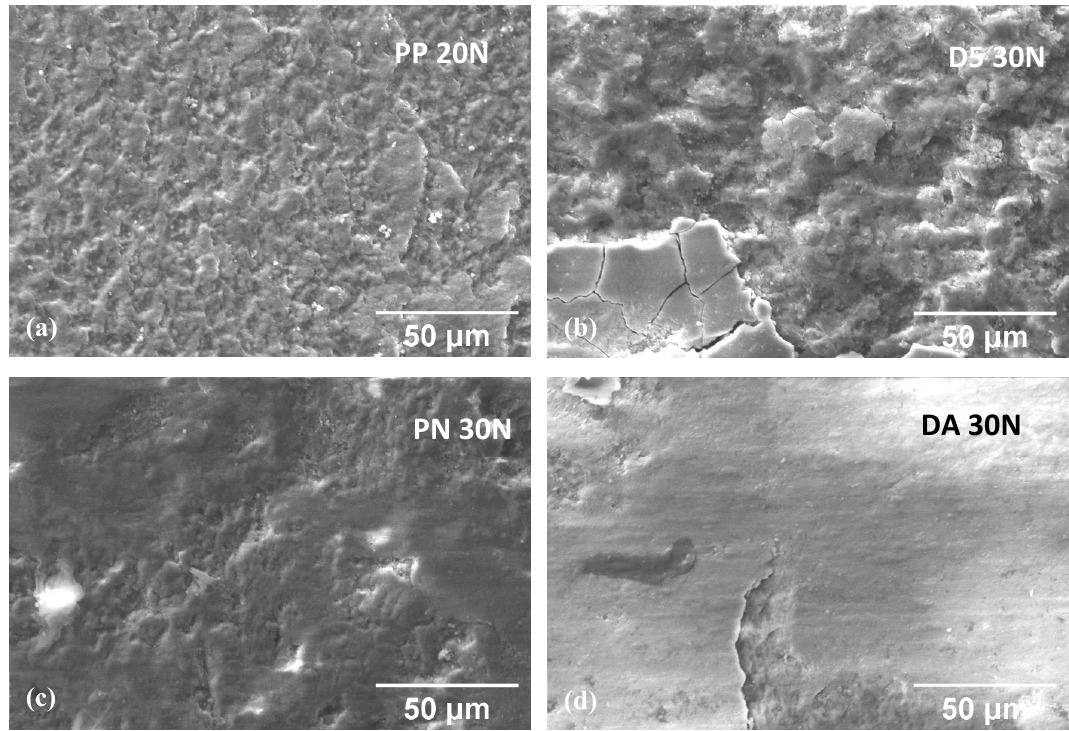
Figure 12. SEM images of wear scars at the load before coating failure for PEO coatings which survived at loads higher than 10 N: single layers (PP: a , PN: c ) and double layers (D5: b , DA: d ).